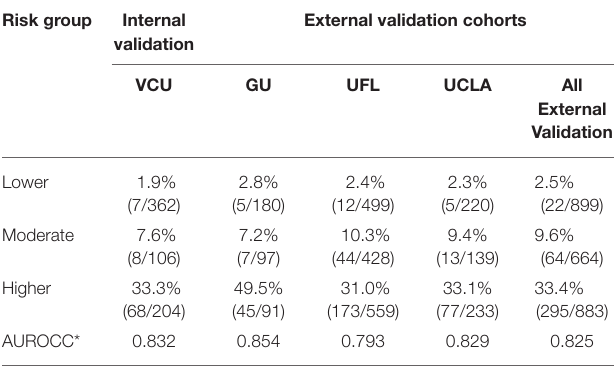
TABLE 2 | Validation of the two-step coronavirus disease 2019 risk score in 4 populations